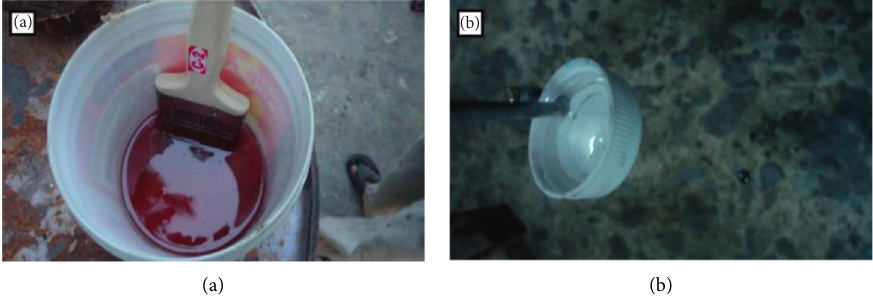
Figure 8: (a) Epoxy resin. (b) Mixing